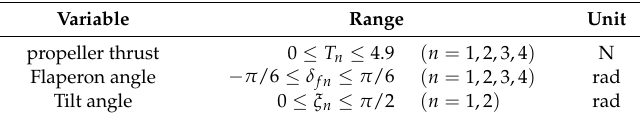
Table 3. Constraints of actuator.